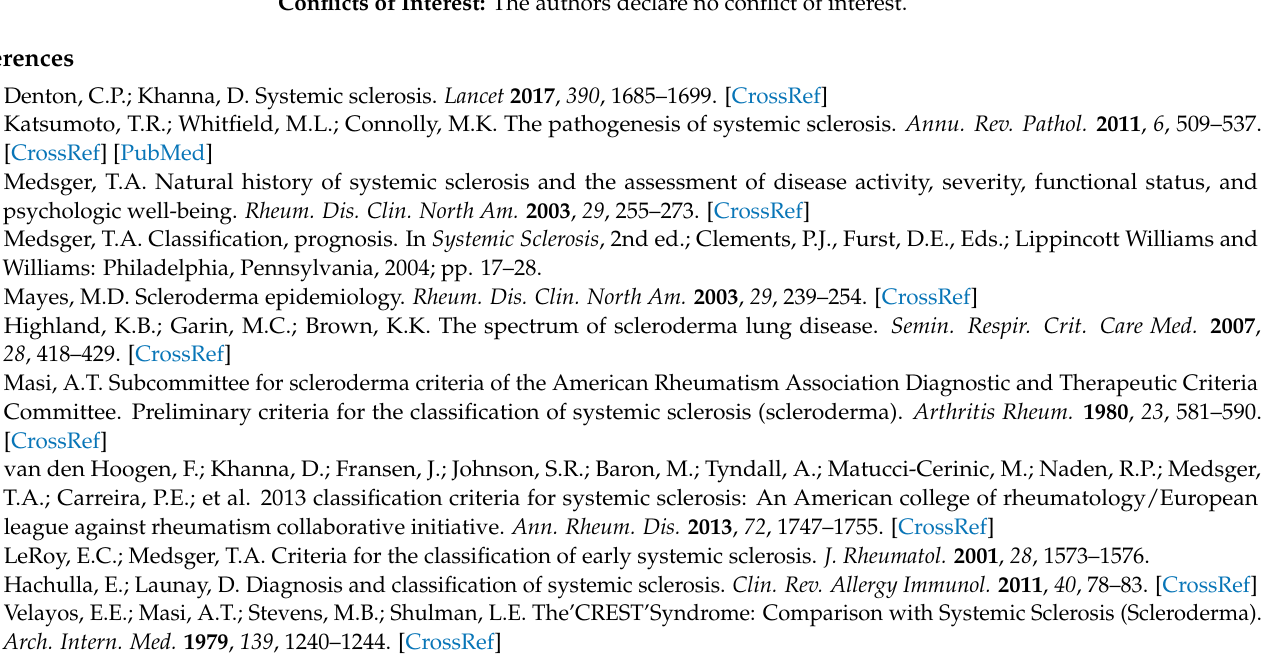
description: Table S1: Summary of indications and pitfalls for various imaging modalities in different clinical forms of systemic